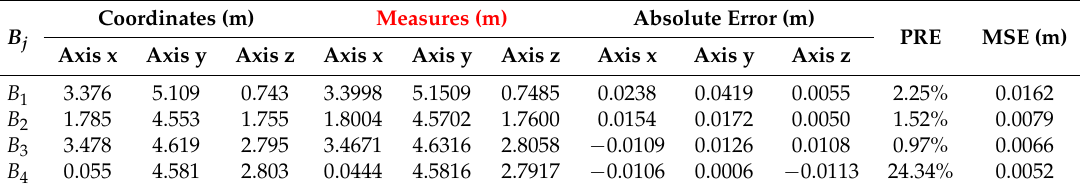
Table 2. Experimental measurements in the calibration